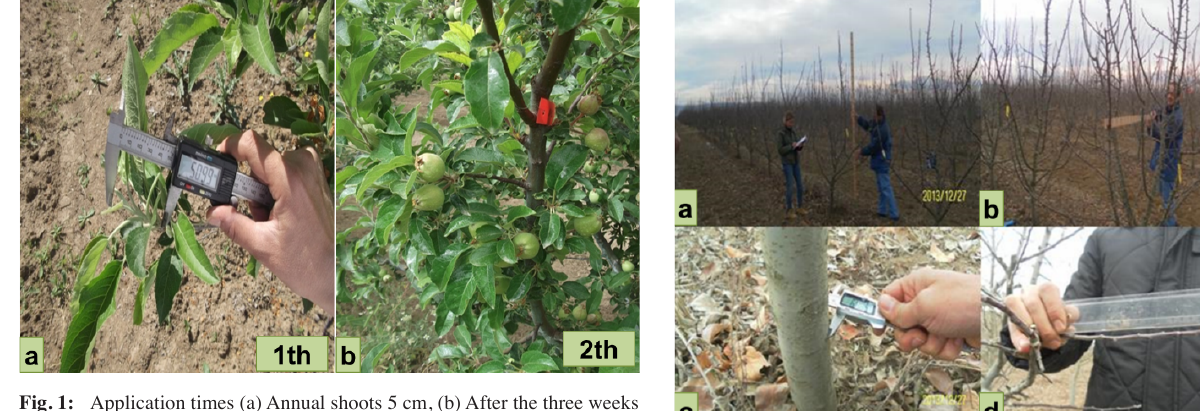
Fig. 1: Application times (a) Annual shoots 5 cm, (b) After the three weeks